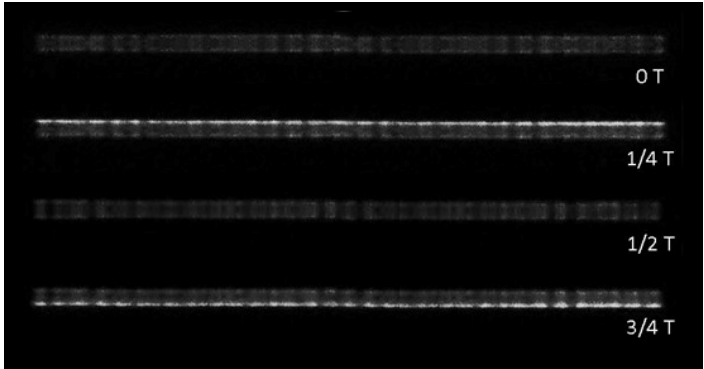
The ICCD camera was triggered by the signal of the current when it crosses zero forward, and four photos within one discharge cycle (73.7 ns) were obtained, as shown in Figure 10. The single exposure time was 2 ns, and the four photos corresponded to 0 T, 1/4 T, 1/2 T and 3/4 T of the discharge cycle. In the first half-cycle, during which the upper water electrode is a cathode, positive ions are forced upward to reach the cathode, resulting in a large amount of wall charge accumulated on the surface of the water electrode at 1/4 T. Since these wall charges are all positively charged, repulsive forces are generated between each other, and eventually the filaments form a balanced structure as a hexagonal shape. The second half of the period is consistent with the first. With the increase of power, more and more charges accumulated on the surface of the cathode, which made the inner which made the inner repulsive force of the wall charges generated by one single fila- repulsive force of the wall charges generated by one single filament become larger and ment become larger and larger, and finally split into a cluster of multiple roots. larger, and finally split into a cluster of multiple roots.